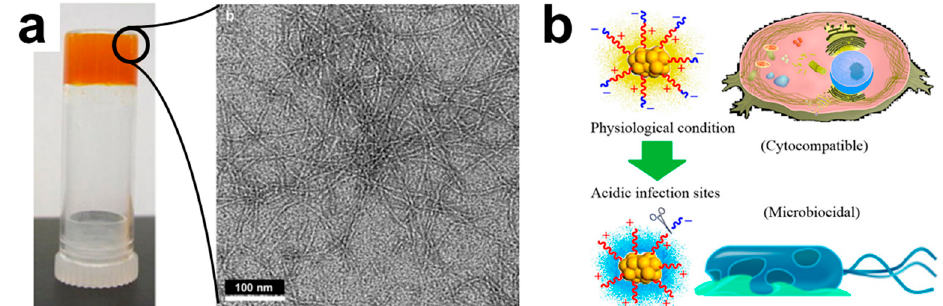
Figure 14. ( a ) Macroscopic (left) and TEM image (right) of a curcumin loaded MAX8 gel. Reprinted from [153] with permission from Elsevier. ( b ) Schematic image of site-specific cleavage of antimicrobial peptides from the gold nanocluster in acidic infection sites for targeted, bioresponsive activity. Reprinted with permission from [210]. Copyright 2019 American Chemical Society.